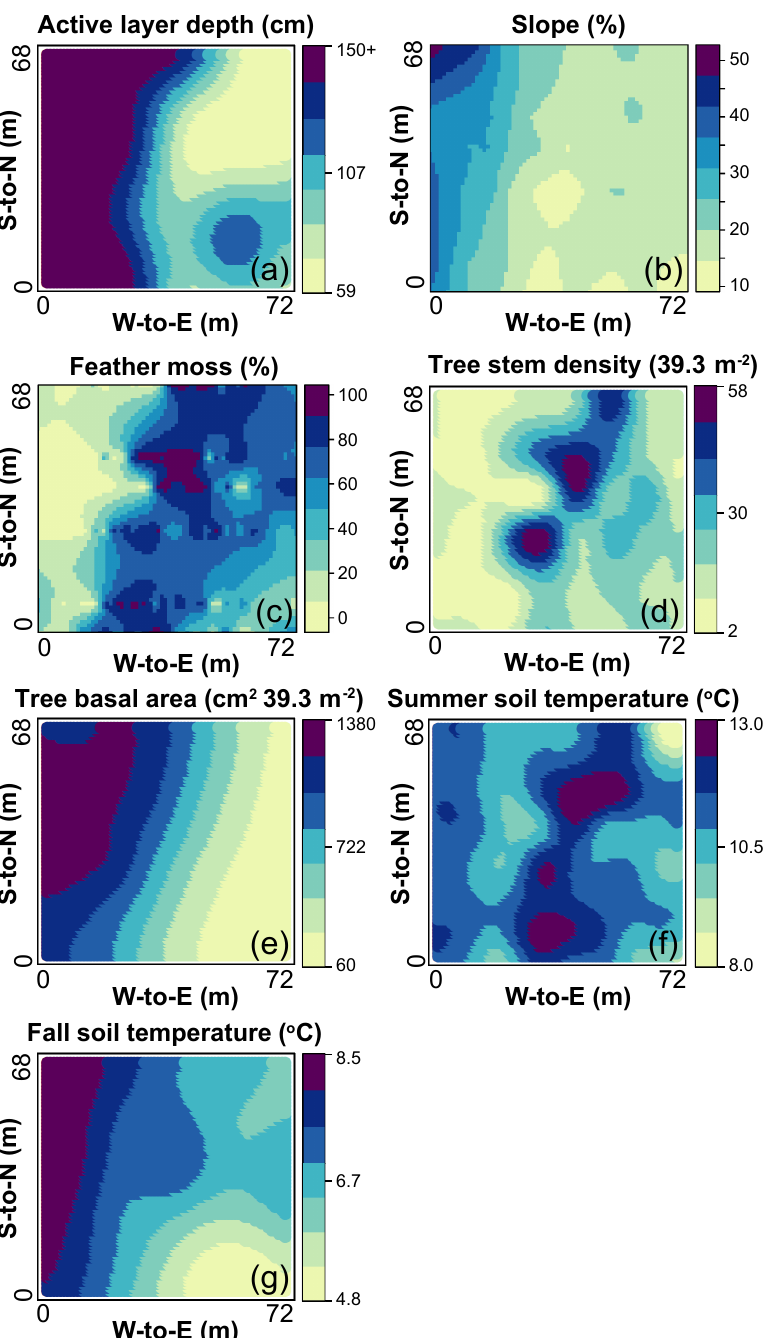
Figure 2. Interpolated environmental variables. Each panel has its own color ramp, and units are noted. The vertical and horizontal axes in all panels indicate the south-to-north and west-to-east dimensions, respectively. Interpolations are based on fitted variograms. Active layer depth of 150 + indicates that the probe had a maximum depth of 150cm whereby permafrost occurring deeper than 150cm could not be